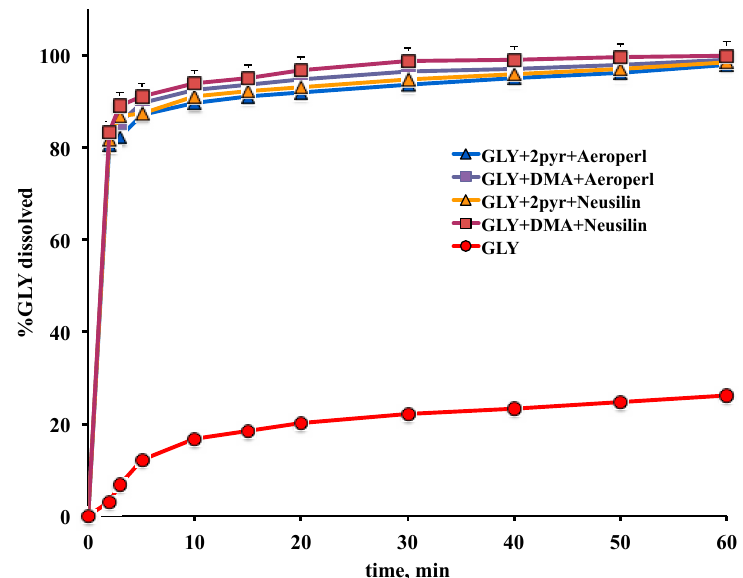
Figure 6. Dissolution profiles of glyburide (GLY) as such or from the different liquisolid systems.